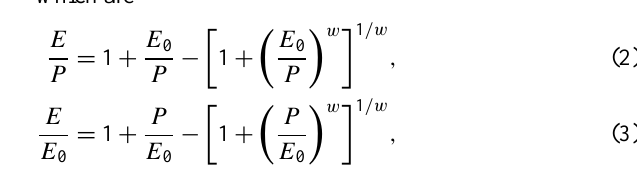
Table 1. Seven periods selected in the past 2000 years. Dynasty Start End Main production Selected periods Han Dynasty 206BC AD220 Agriculture The beginning of the 1st century AD Wei-Jin era AD220 AD420 Animal husbandry The end of the third century AD Tang Dynasty AD618 AD907 Agriculture The mid-8th century AD Yuan Dynasty AD1271 AD1368 Animal husbandry The end of the 13th century AD AD1368 AD1644 Agriculture The mid-16th century AD Agriculture The mid-18th century